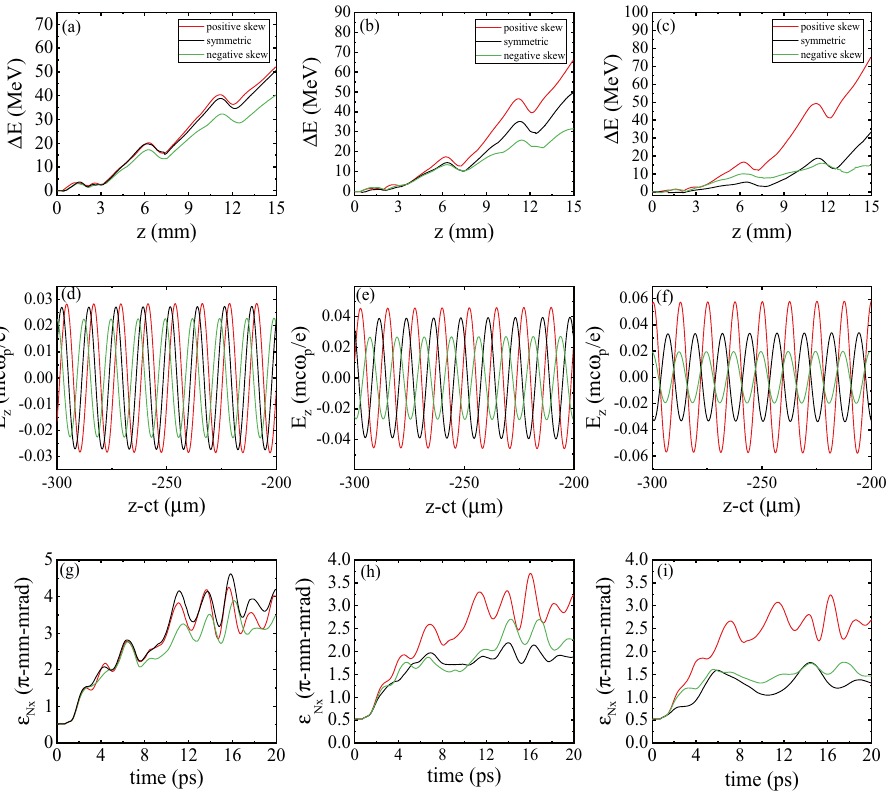
Figure 6. ( a – c ) show the variation of the maximum energy gain (cid:31) E as a function of axial distance for ( a ) 20 fs, ( b ) 30 fs and ( c ) 40 fs pulses; ( d – f ) show the corresponding longitudinal wakefields at t = 40 ps; ( g – i ) show the corresponding transverse emittances, ε N, x , as a function of the propagation time. The red, black, and green colors denote the positive skew, the symmetric, and the negative skew cases, respectively. In the simulations, the laser pulse is linearly polarized with a peak amplitude of a 0 = 0.25 , a wavelength of 800 nm, and a focal spot size (FWHM) of w 0 = 15